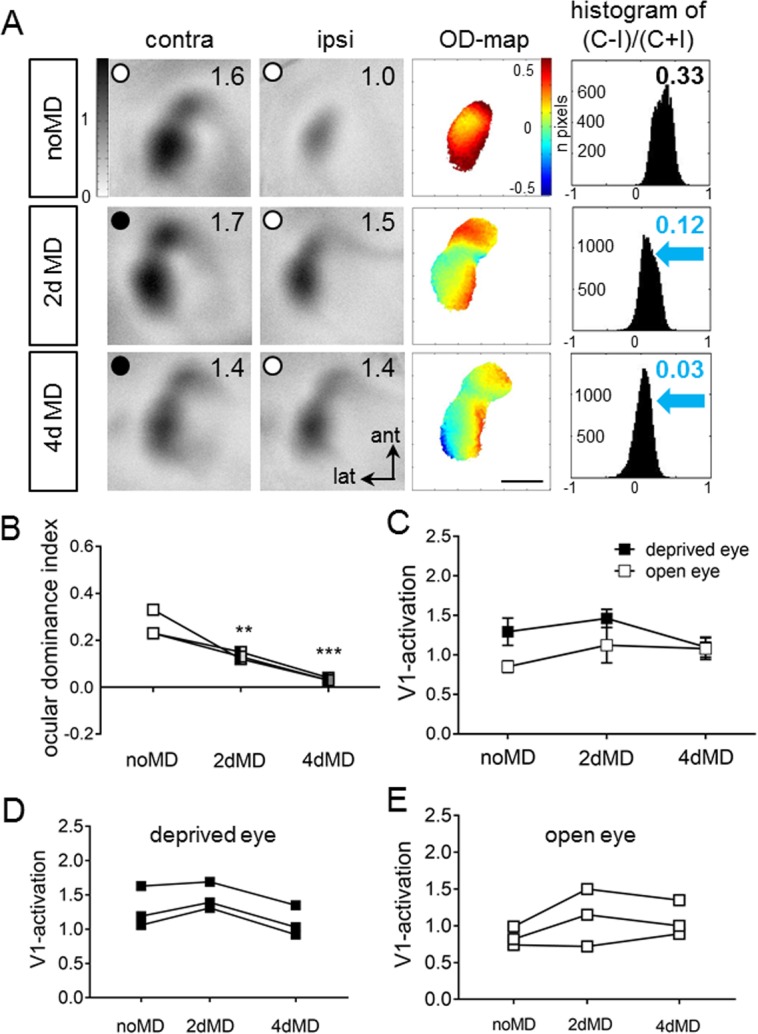
Ocular dominance-shifts happen already after 2 days of monocular deprivation in adult enriched environment mice.Chronic imaging of V1-activation in enriched environment (EE)-mice before and after monocular deprivation (MD), and its quantification. A: V1-activity maps of a P143 EE-mouse after visual stimulation of the contra- (contra) and ipsilateral (ipsi) eye, before (noMD, first row) and after 2/4 days of MD (second/third row). Layout and data display as in Fig 1. B-E: Ocular dominance indices (B), average V1-activation (C) and individual V1-activation after deprived and open eye stimulation before and after MD of the three chronically imaged EE-mice.